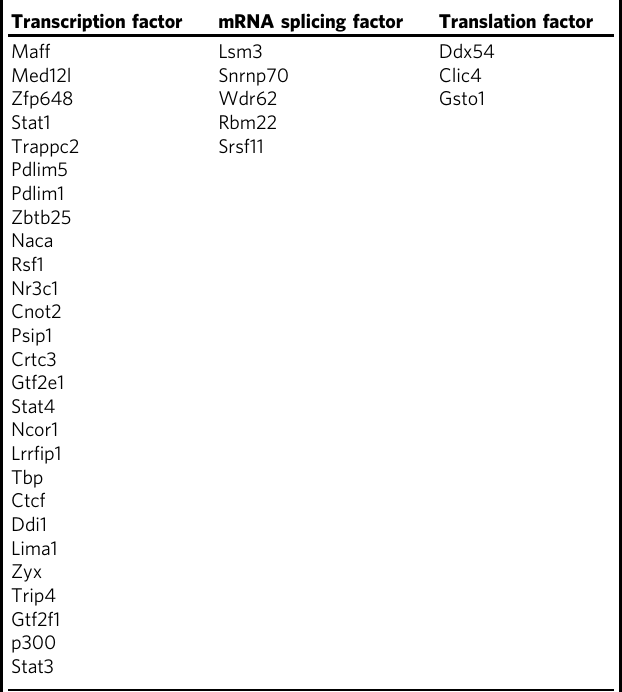
Table 1 Characterization of PU.1 complexes in T H 9 cells Table 2 PU.1 complexes are associated with